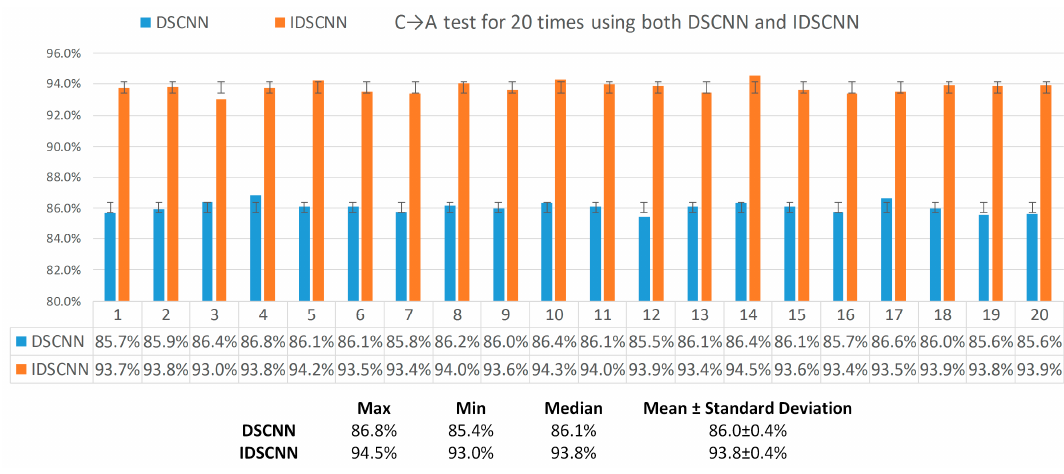
Figure 10. Performance comparison of DSCNN vs IDSCNN on C → A test.